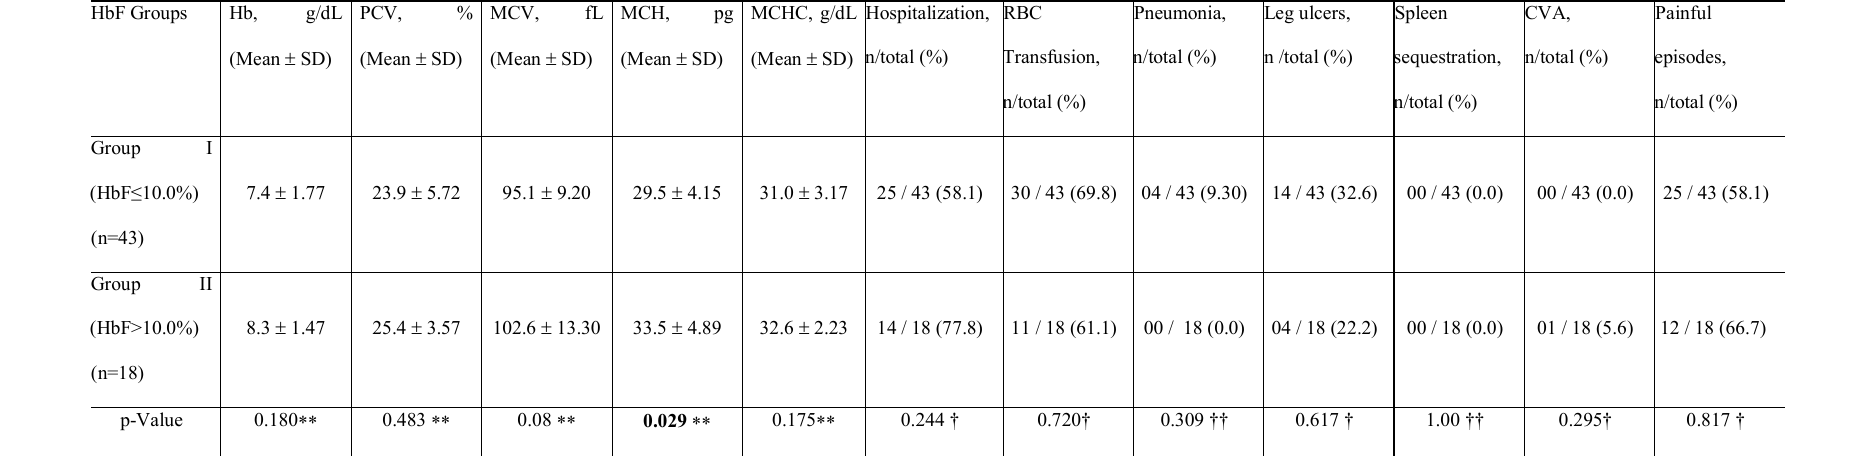
Hematological and clinical characteristics in sickle cell anemia patients from Bahia, Brazil, with age > 18.0 years and and